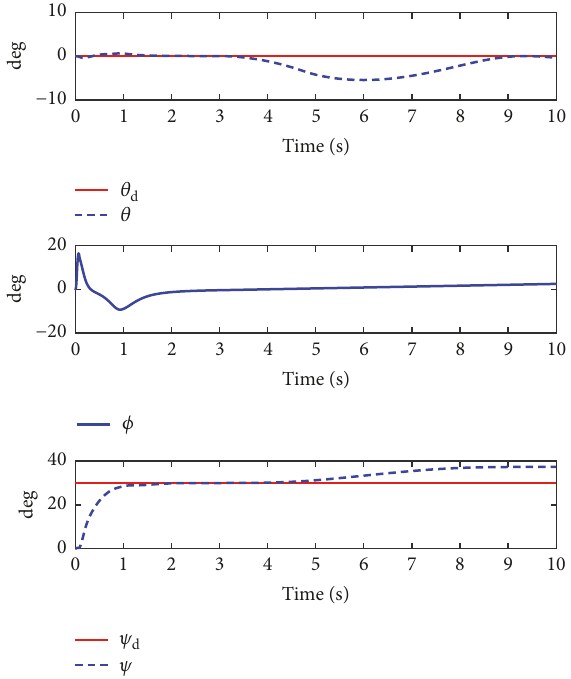
Figure 11: Attitude control during transition